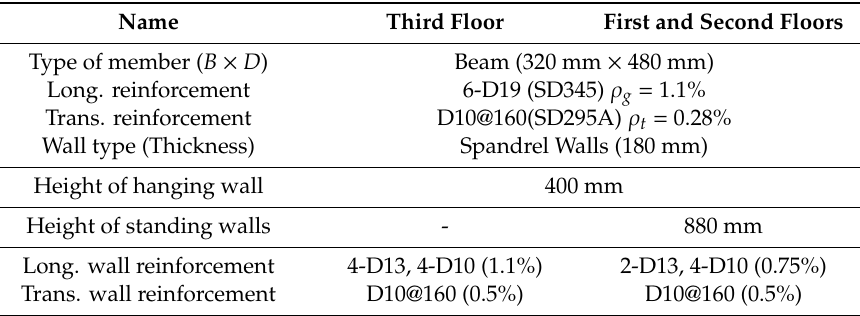
Table 5. Hanging walls—reinforcement details.